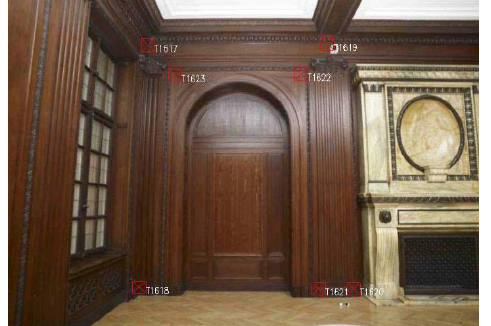
Picture 10: Undistorted